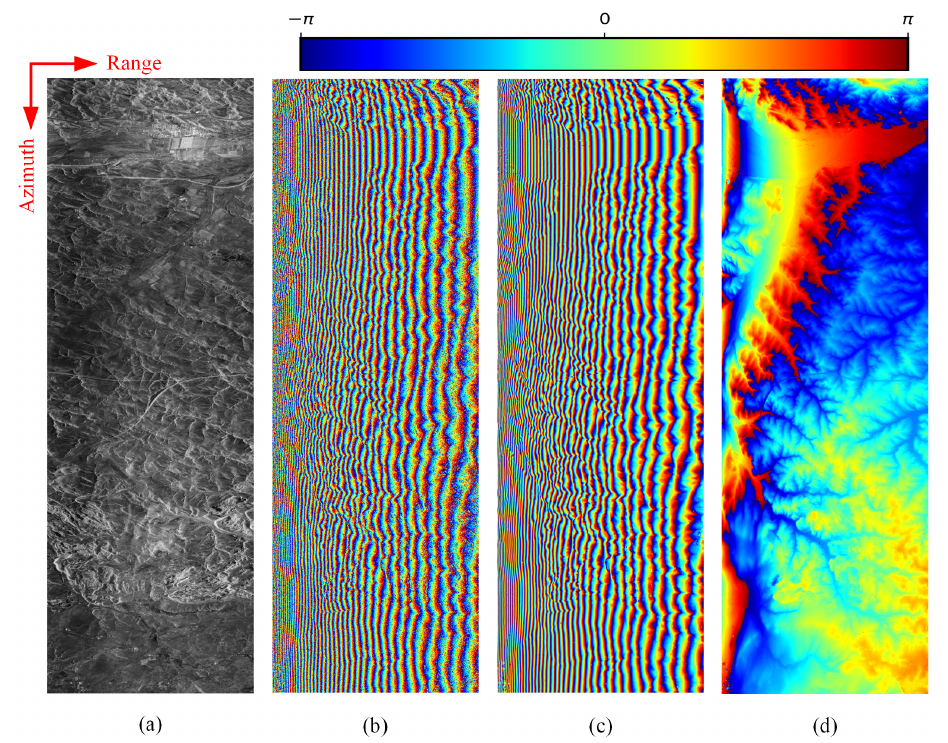
Figure 15. Experimental data. ( a ) The corresponding SAR image of the experimental area. ( b ) Real interference fringe with noise. ( c ) Real interference fringe after noise removal. ( d ) Real interference fringe after removing the leveling